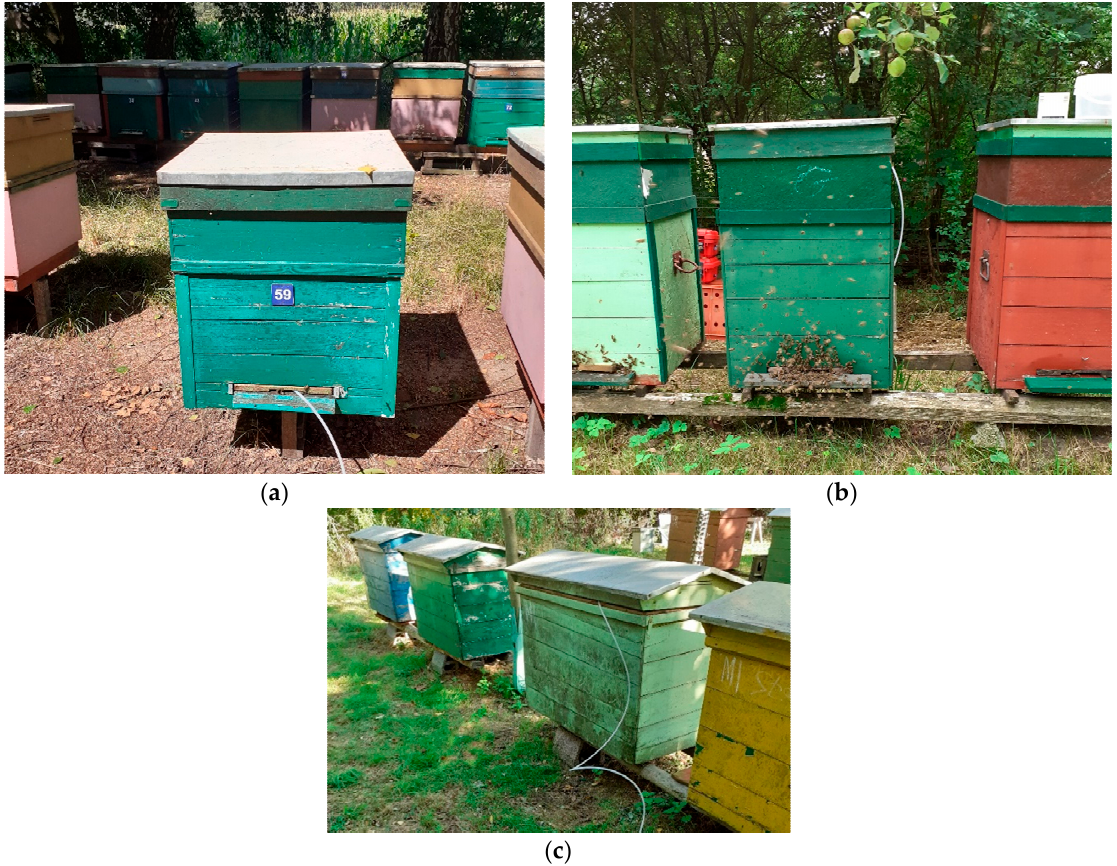
Figure 2. Different kinds of beehives, which were included in the study. They were wooden. They were built by beekeepers. ( a ) Apiary 1 located on the border between forest and field, ( b ) Apiary 2 located in the garden, ( c ) Apiary 3 located on the border between forest and field.